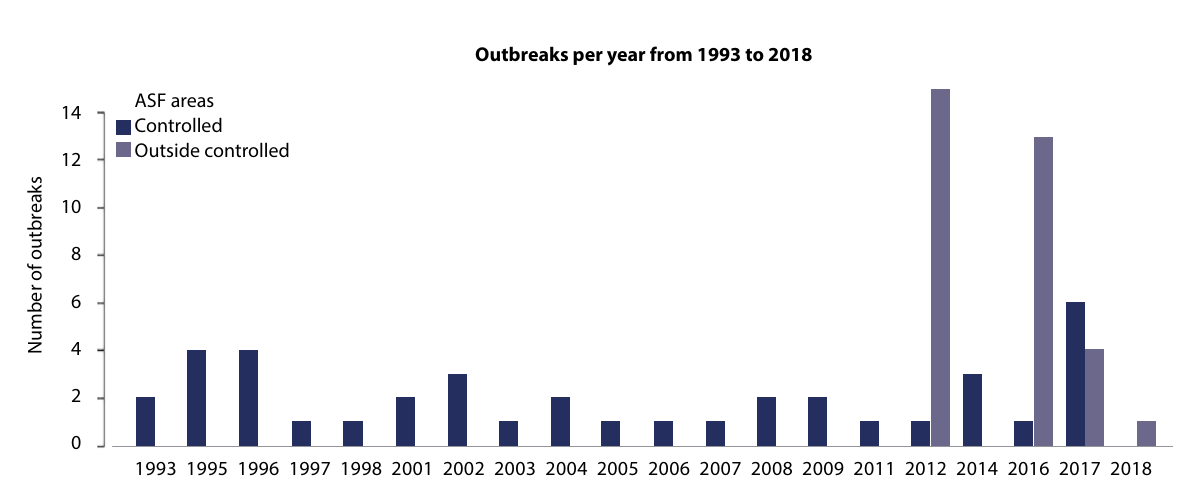
Figure 1: Temporal distribution of ASF in South Africa from 1993 to 2018; only the years in which outbreaks occurred are represented in Figure 1